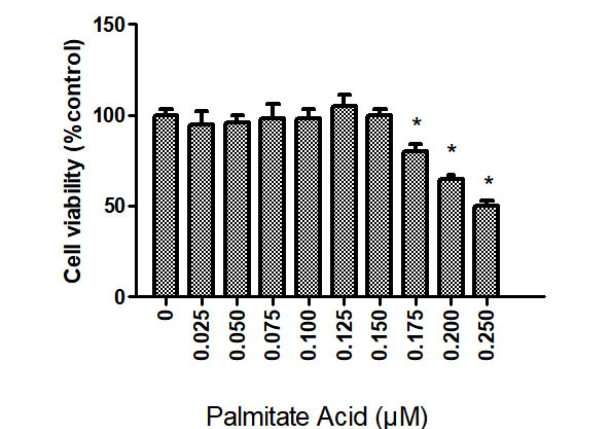
FIGURE 1 - Cytotoxicity of PA in HepG2 cells. HepG2 cells were incubated with various concentrations of XZK for up to 24 h and cell viability was determined by MTT assay. Results were expressed as the mean±SEM of three independent experiments